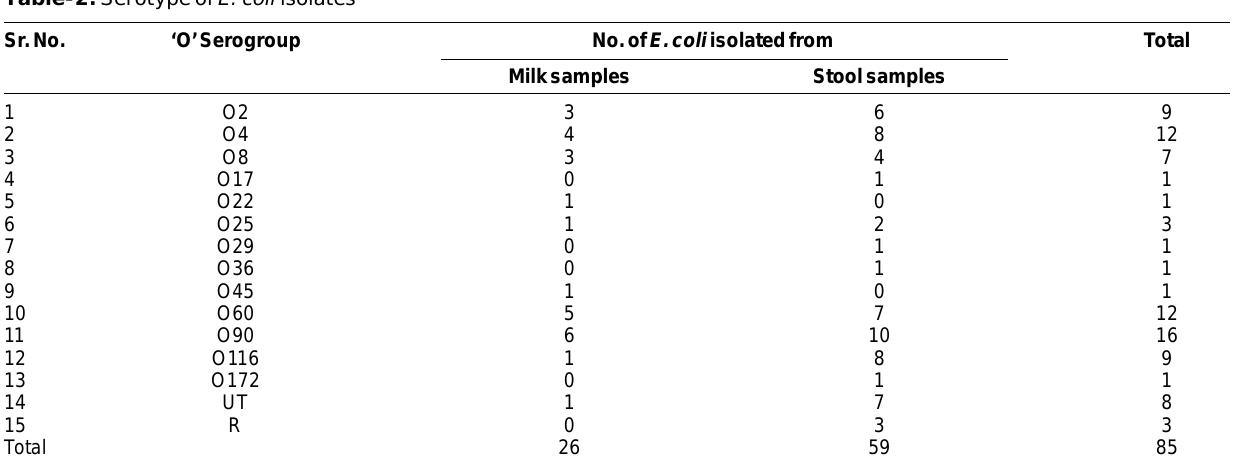
Table-3. PCR amplification of virulence genes Sr. No.